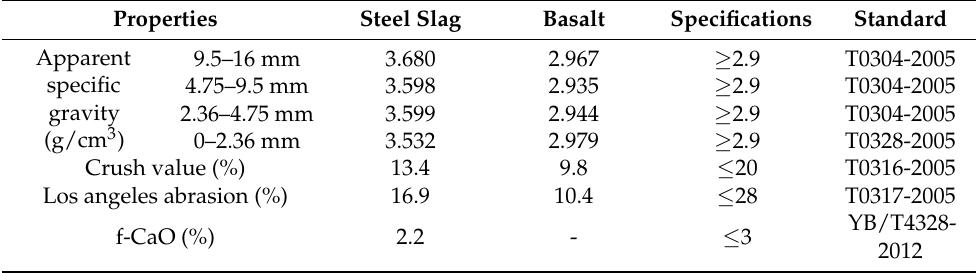
Table 4. Characteristics of aggregates in the asphalt mixture.